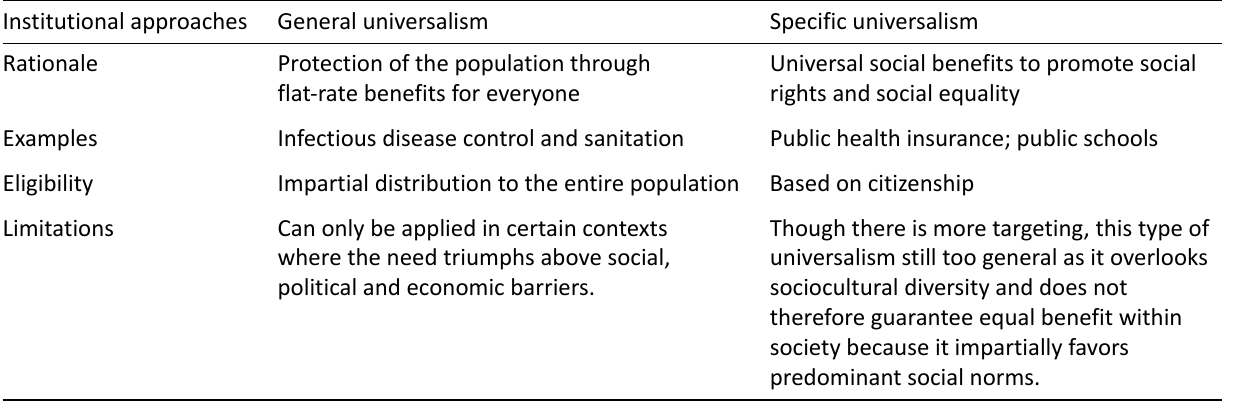
Table 2. Operational overview of universalism as institutional approaches. Adapted from Carey and Crammond (2017). Institutional